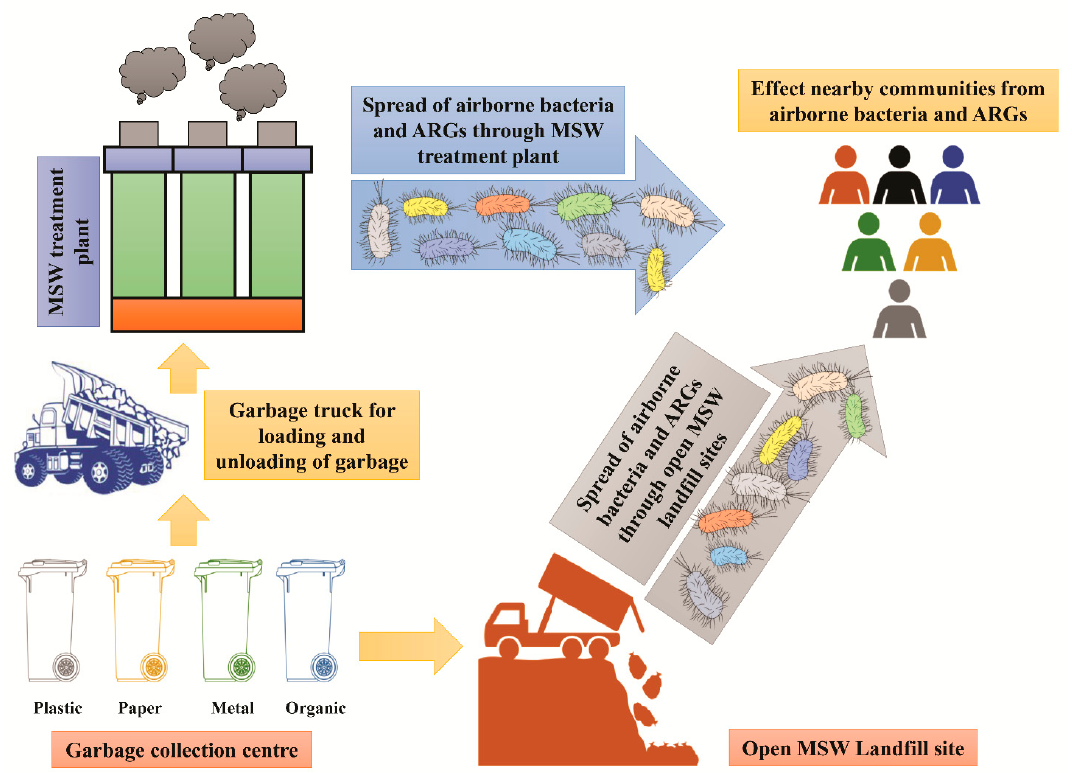
Figure 4. The diagram explains the dissemination of airborne bacterial pathogens during the loading and unloading of garbage vehicles and the spread of ARB from open MSW landfill sites and MSW treatment plants to the nearby human population.